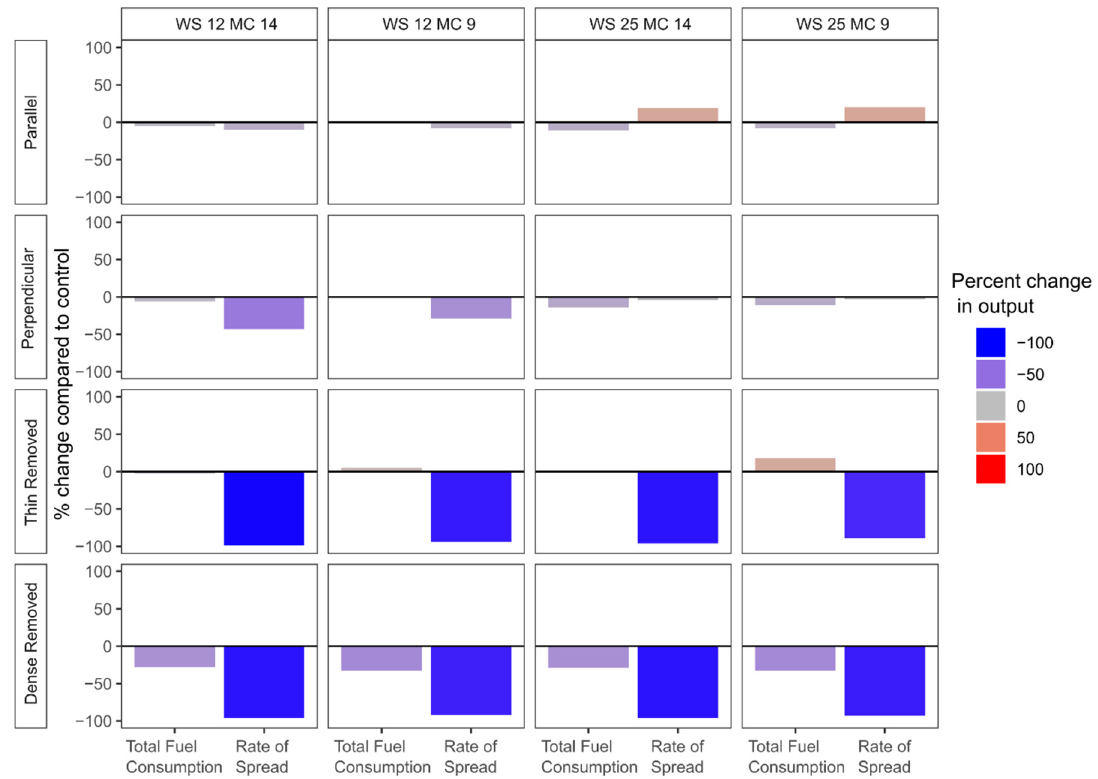
Figure 2. Fuel consumption and rate of spread change for each treatment and weather scenario in the black spruce fuel type. All changes are percent change relative to the control simulation in the same weather scenario.